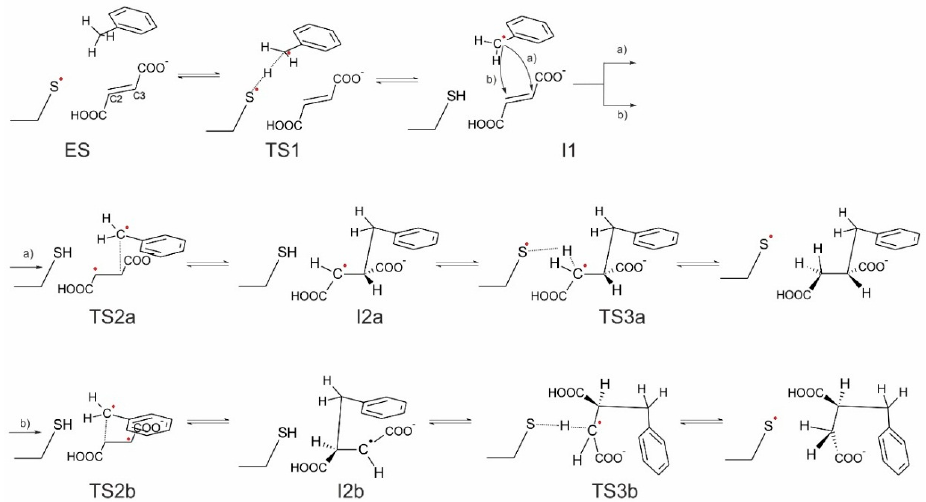
Figure 7. The mechanism of reaction with two variants: attack on distal carbon atom (pathway ( a ))